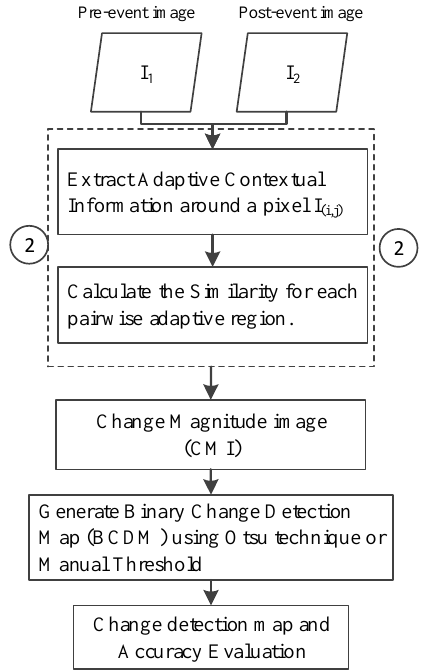
Figure 1. Flowchart of the proposed approach.